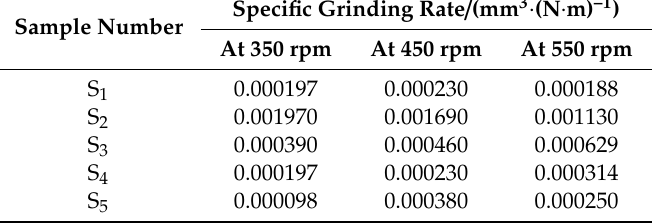
Table 4. Specific wear rates of palm-kernel particles of type 1 composites at di ff erent velocities and volume